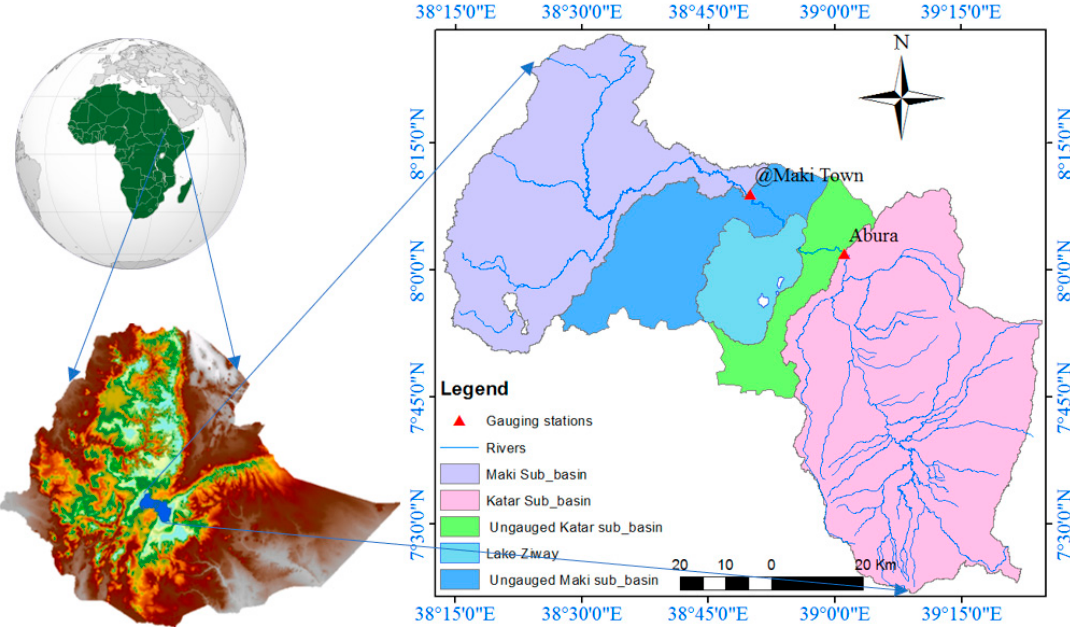
Figure 1. Location of Lake Ziway basin in Ethiopia.